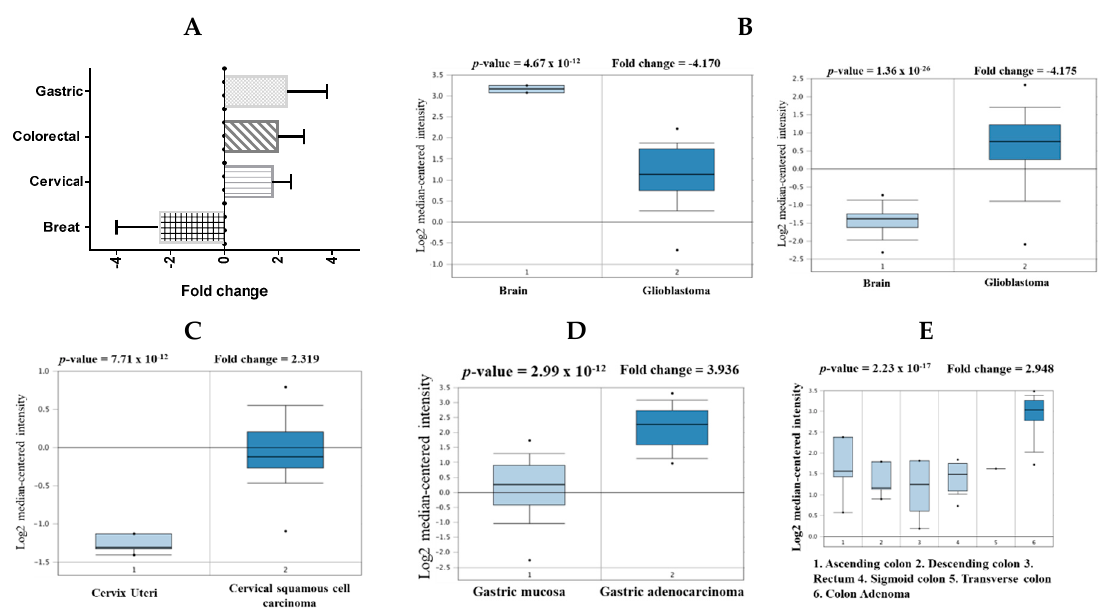
Figure 2. CHEK1 analysis in different cancer types. The box plot comparing specific CHEK1 expression in normal (left plot) and cancer tissue (right plot) was derived from the Oncomine database. The fold change of CHEK1 in various types of cancers was expressed as the forest plot ( A ). The analysis was shown in two sample types, glioblastoma carcinoma relative to normal brain ( B ), in cervical carcinoma relative to normal cervical tissue ( C ), in gastric carcinoma relative to normal gastric tissue ( D ), and in colorectal carcinoma relative to normal colorectum ( E ).